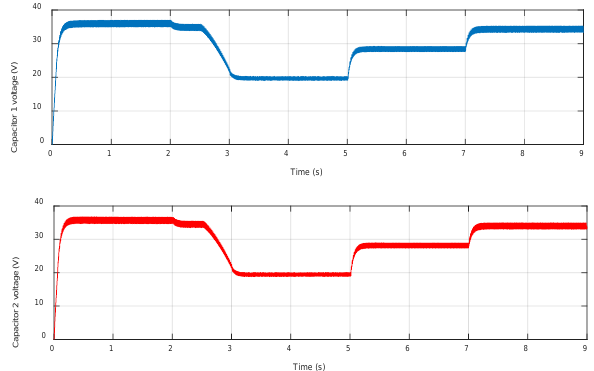
Figure 13. SPUC5 capacitor voltages.